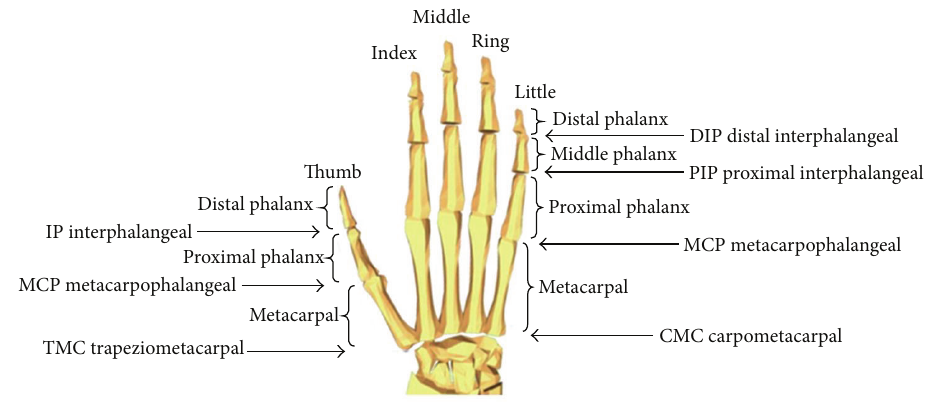
Figure 1: Anatomical details of the hand skeleton. Table 3: Mean length of the hand and of the phalanges of index, middle, ring, and little fingers (cm).